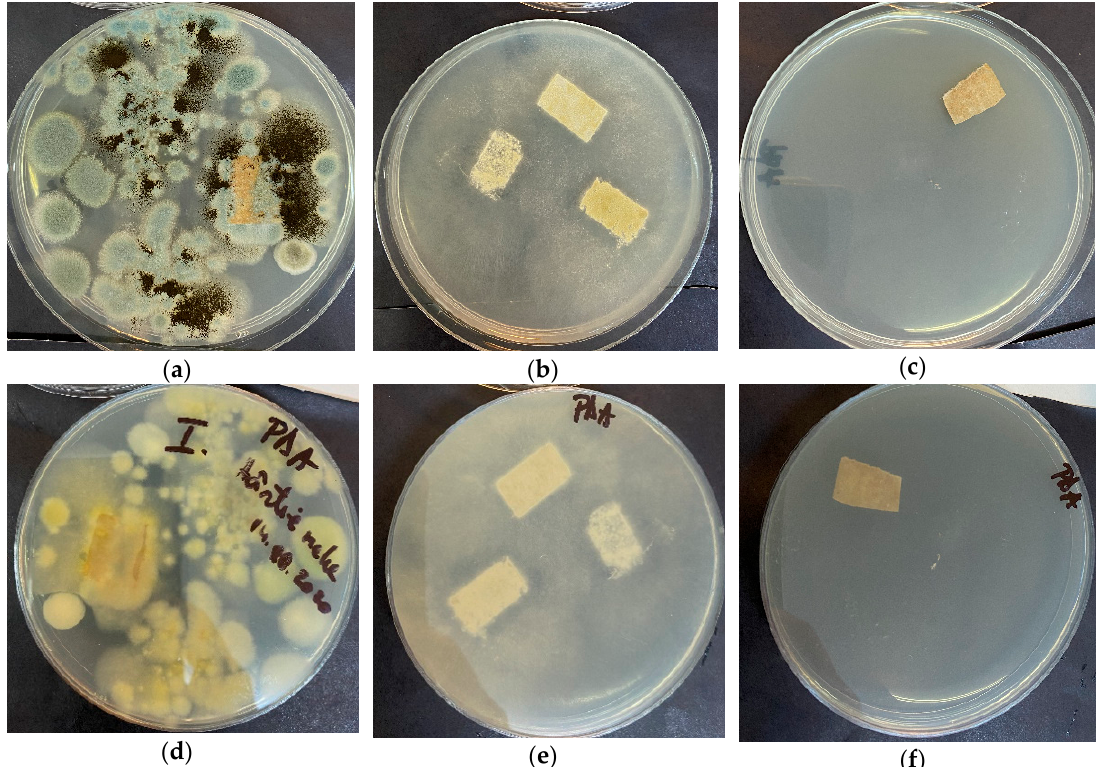
Figure 14. Aspect of mold cultures obtained in potato dextrose agar (PDA) after three-point inoculation using untreated and ZnO NPs treated old book specimens. Sample A ( a , d ) paper specimen with microfungi colonization and biodegradation aspect (a—surface; d—reverse); sample B ( b , e ) paper specimen with microfungi colonization and biodegradation aspect (b—surface; e—reverse); sample A_ZnO ( c , f ) treated paper specimen (c—surface; f—reverse).